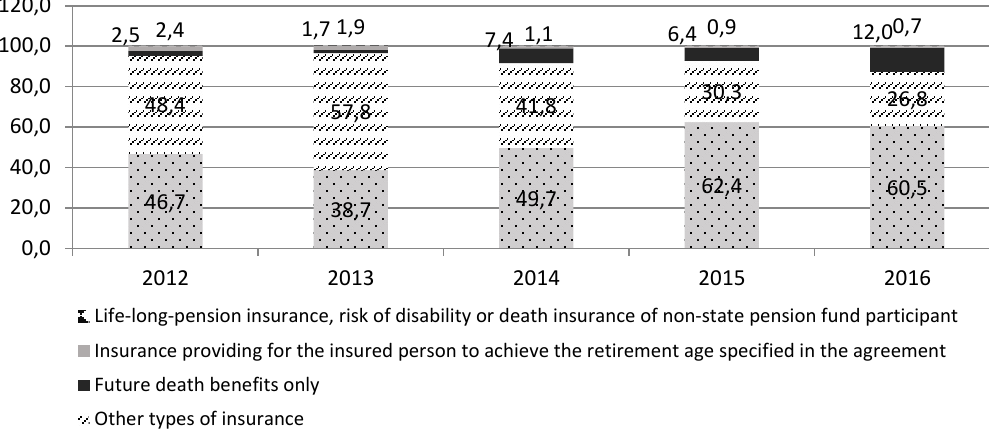
Figure 3. Life insurance according to types in Ukraine during